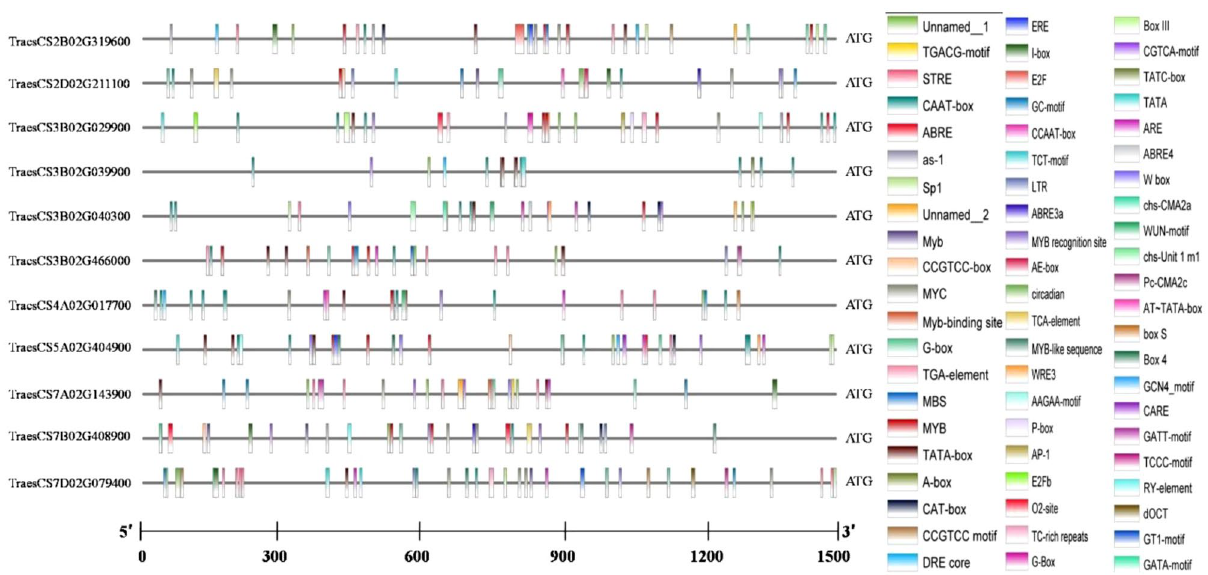
Figure 5. Information on cis-regulatory elements in promoter regions of 11 multiple abiotic stress tolerance genes identified during the present